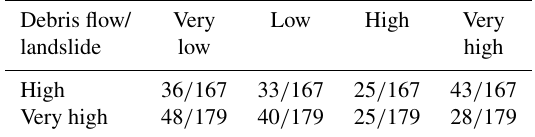
Table 9. The overlap of the number of landslide and debris flow high- and very-high-class mapping units.